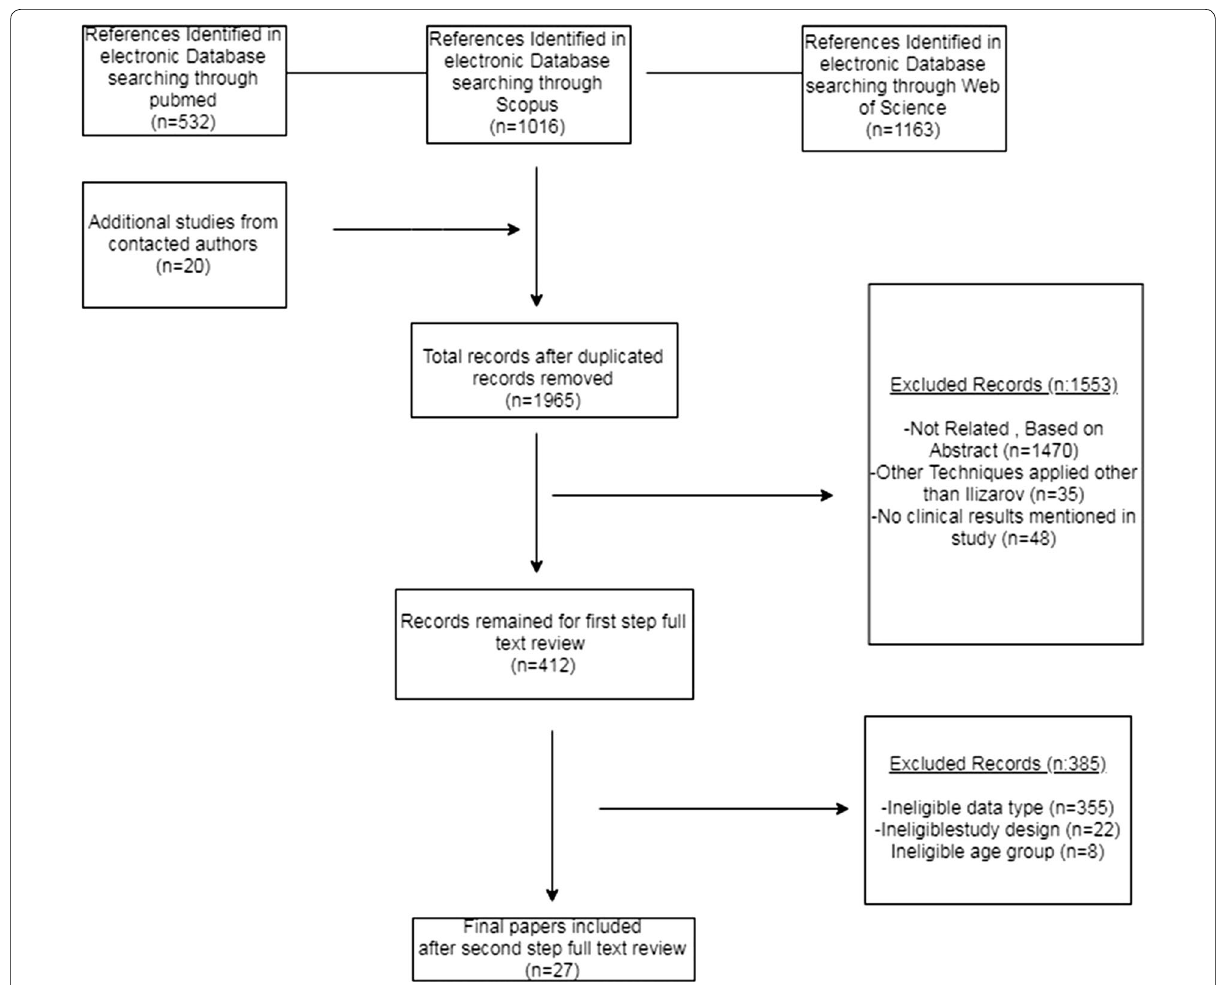
Fig. 1 Flow chart of the literature